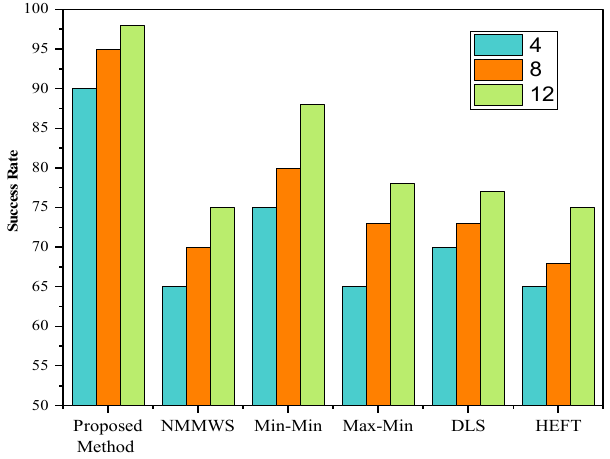
Figure 16. Success rate on the Epigenimics workflow.